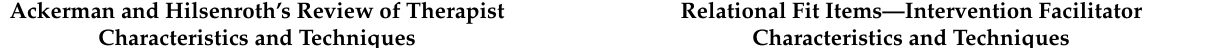
Relational Fit Items—Intervention Facilitator Characteristics and